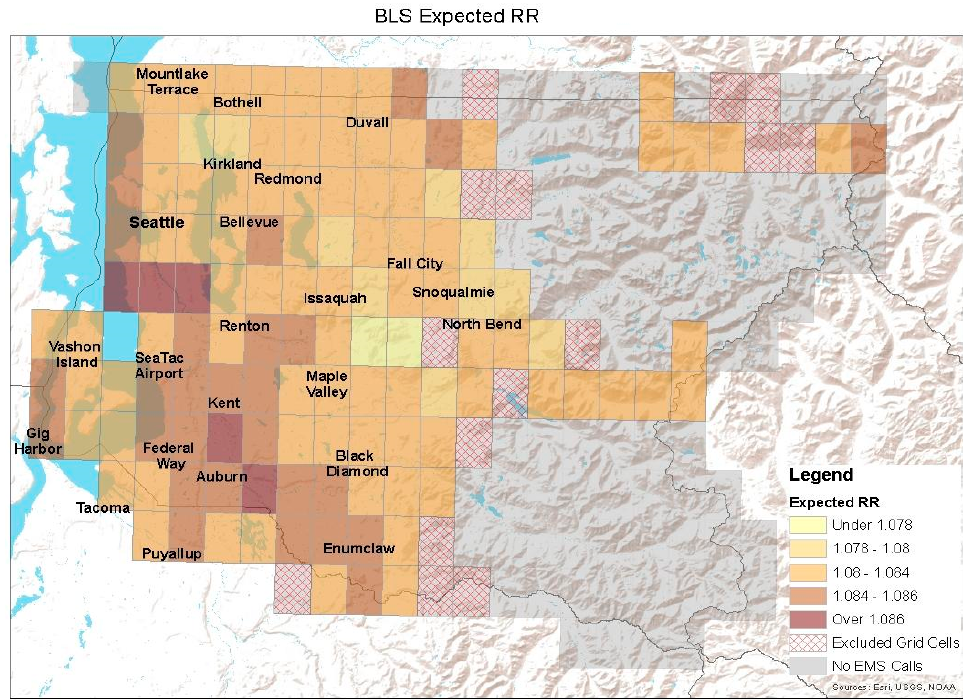
Figure A1. King County, Washington’s Grid map of expected RRs for BLS data with local city labels, where red checkers indicate grid cells without call data or too few call data to be included in the analysis. Each grid cell has size of 4 km by 7.5 km.